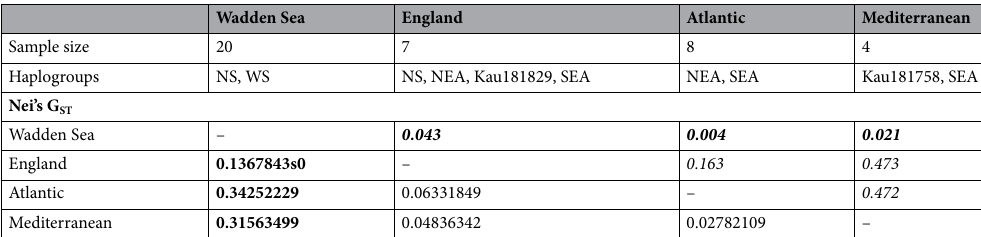
Table 1. Results of Nei’s G ST pairwise analyses of O. edulis populations from sampling sites with more than four sampled individuals. Pairwise p-values are shown in the top triangle (italics background). Values with significance are bolded (p-value <